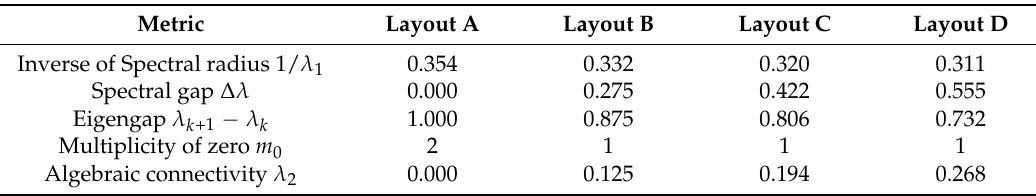
Table 1. Spectral metrics for the four cases of the example network.